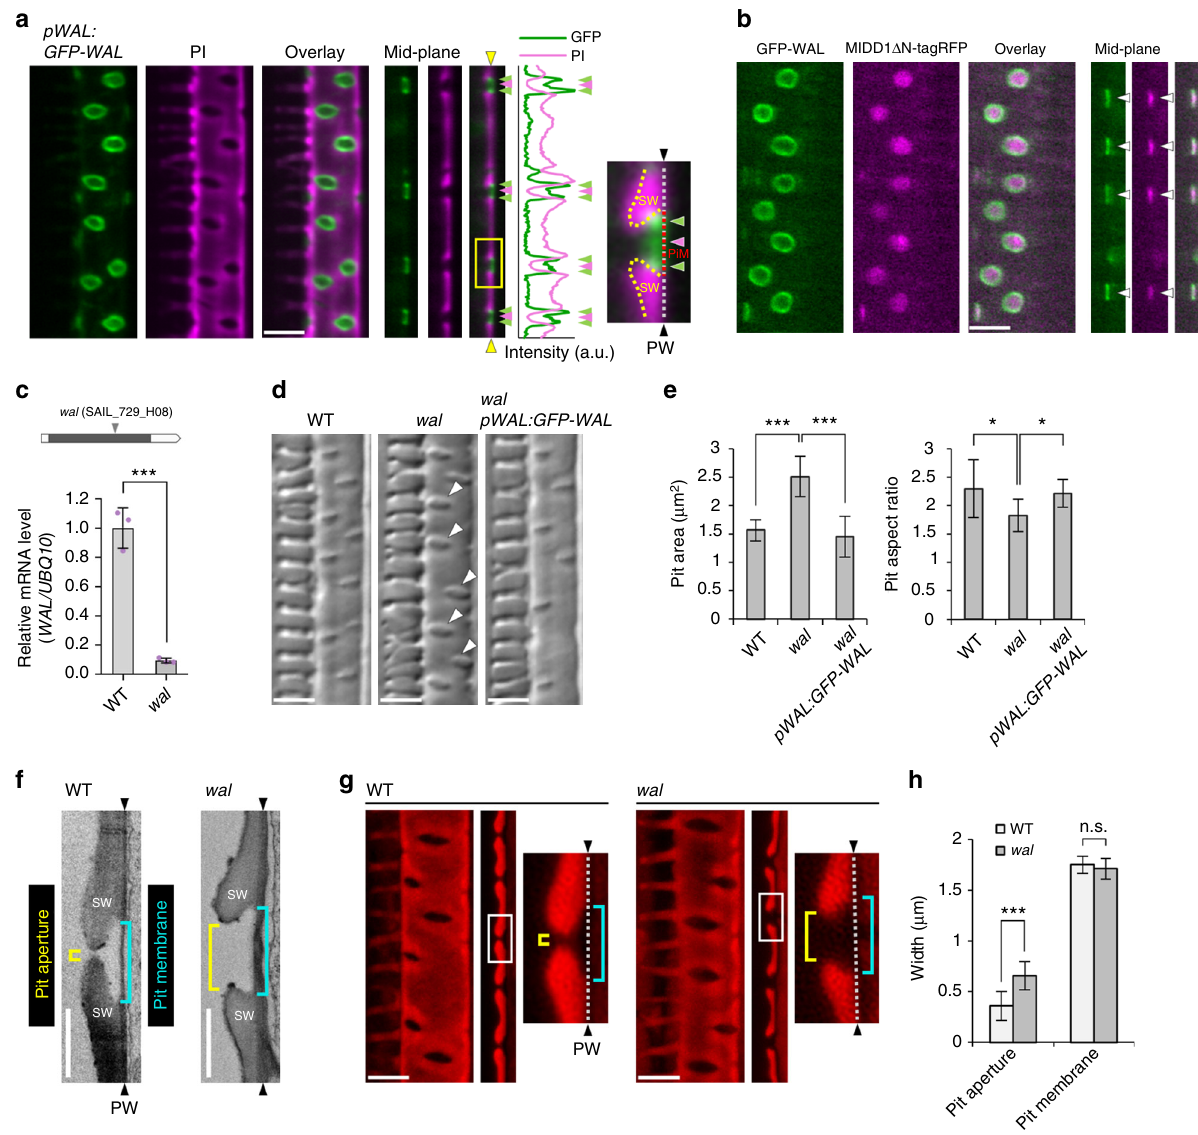
Fig. 1 WAL is required for cell wall arches of pits. a Localization of GFP-WAL ( pWAL:GFP-WAL ) in metaxylem vessel cells in roots. Cell walls are labeled with propidium iodide (PI). Cortex (left) and mid-plane (right) from different cells are shown. The graph shows the intensity pro fi le between the yellow arrowheads. GFP-WAL (green arrowheads) localized to the pit boundaries (red arrowheads). The boxed area is magni fi ed in the right panel. Yellow and red broken lines indicate the edges of secondary cell walls (SW) and pit membranes (PiM), respectively. b Localization of GFP-WAL and active ROP11 domains ( pMIDD1:MIDD1 Δ N-tagRFP ) in metaxylem vessel cells in roots. Cortex (left) and mid-plane (right) from different cells are shown. c WAL mRNA abundance in wal (SAIL_729_H08) plants. Values are mean ± s.d. ( n = 3), *** p < 0.001 (Student ’ s t -test). d Differential interference contrast (DIC) of xylem vessels in roots of wild-type, wal , and wal pWAL:GFP-WAL plants. Arrowheads indicate enlarged secondary cell wall pits. e Surface area and aspect ratios of secondary cell wall pits. Values are mean ± s.d. ( n > 300 pits), * p < 0.05; *** p < 0.001 (ANOVA with Scheffe test). f Electron micrographs of metaxylem vessel cells in roots. Yellow and blue brackets indicate pit aperture and pit membrane, respectively. Black arrowheads indicate the position of the primary cell wall layer. g Secondary cell walls of metaxylem vessels in roots of wild-type and wal plants. Secondary cell walls were stained with safranin. High- resolution confocal images were acquired with FV-OSR technology. Maximum intensity projection (left) and mid-plane (center) from different cells are shown. Right panels show magni fi cation of the boxed regions. Yellow and blue brackets indicate pit aperture and pit membrane, respectively. White broken lines indicate the position of the primary cell wall layer. h Width of pit apertures and pit membranes. Values are mean ± s.d. ( n > 240 pits), n.s., not signi fi cant; *** p < 0.001 (Student ’ s t -test). Bars = 5 μ m ( a , b , d , and g ) and 2 μ m ( f ). Source data are provided as a Source Data fi